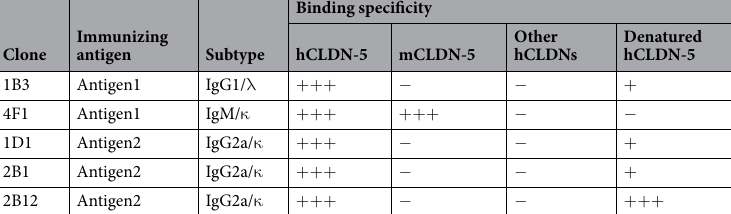
Table 2. Summary of monoclonal anti-CLDN-5 ECR mAbs obtained in this